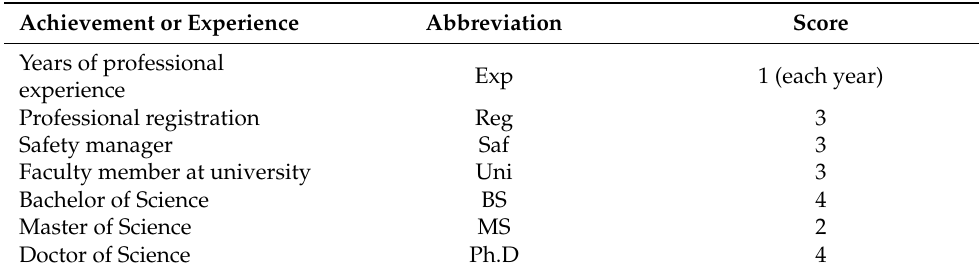
Table 3. Scoring categories for the qualification of